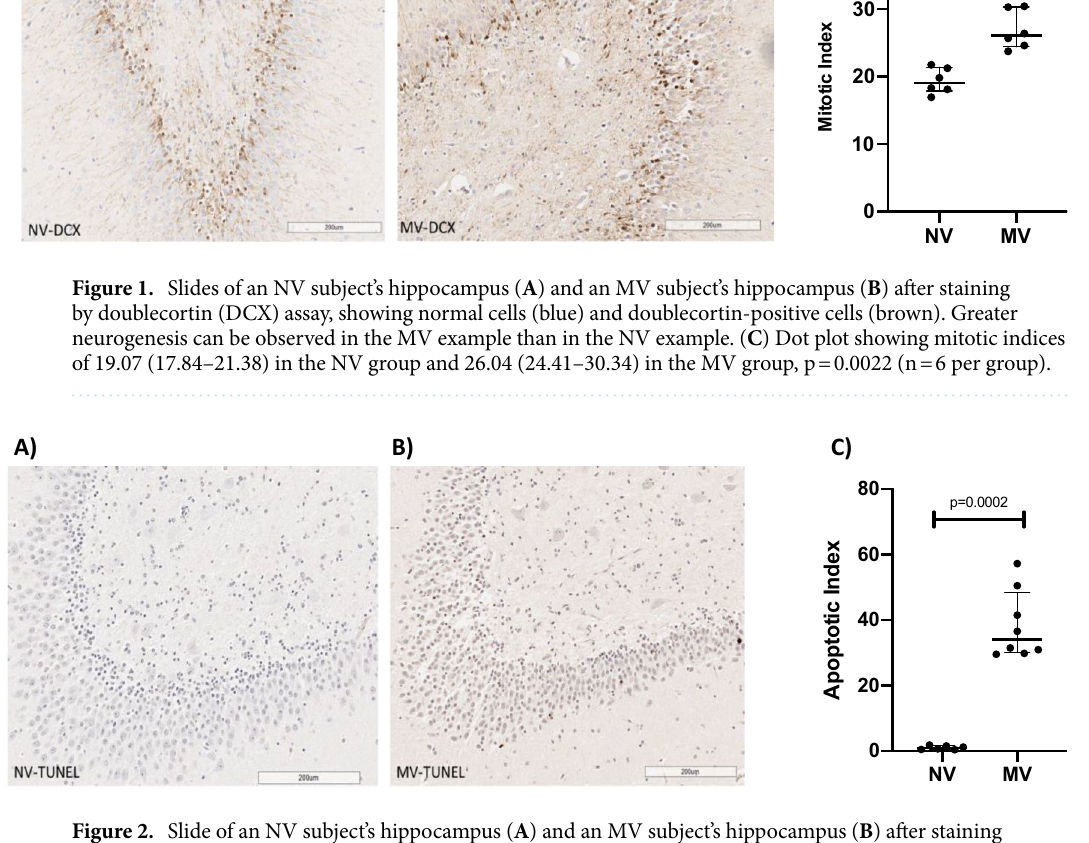
Figure 2. Slide of an NV subject’s hippocampus ( A ) and an MV subject’s hippocampus ( B ) after staining by TUNEL assay, showing normal cells (blue) and TUNEL-positive cells (brown). Considerably greater hippocampal cellular apoptosis can be observed in the MV example than in the NV example. ( C ) Dot plot showing apoptotic indices of 0.96 (0.50–1.61) in the NV group and 31.70 (29.79–43.76) in the MV group p = 0.0002 (n = 6–10 per